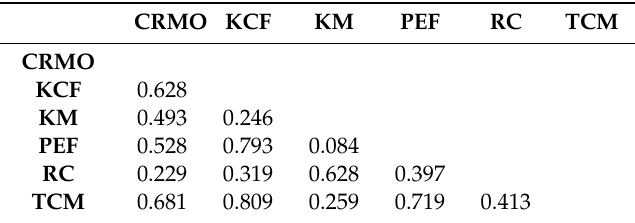
Table 4. The Heterotrait Monotrait Ratio